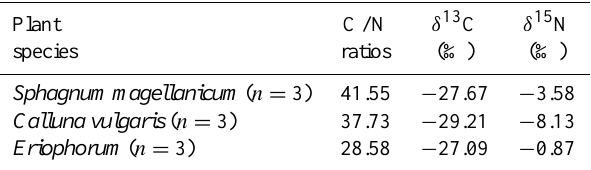
Table 1. Average carbon and nitrogen isotope ratios and C/N ra- tios in plants from two Harz Mountain bogs (KK, KRB). Standard deviation of repeated measurements of isotopic composition were < 0.5‰ and < 0.25‰ for δ 15 N and δ 13 C, respectively.